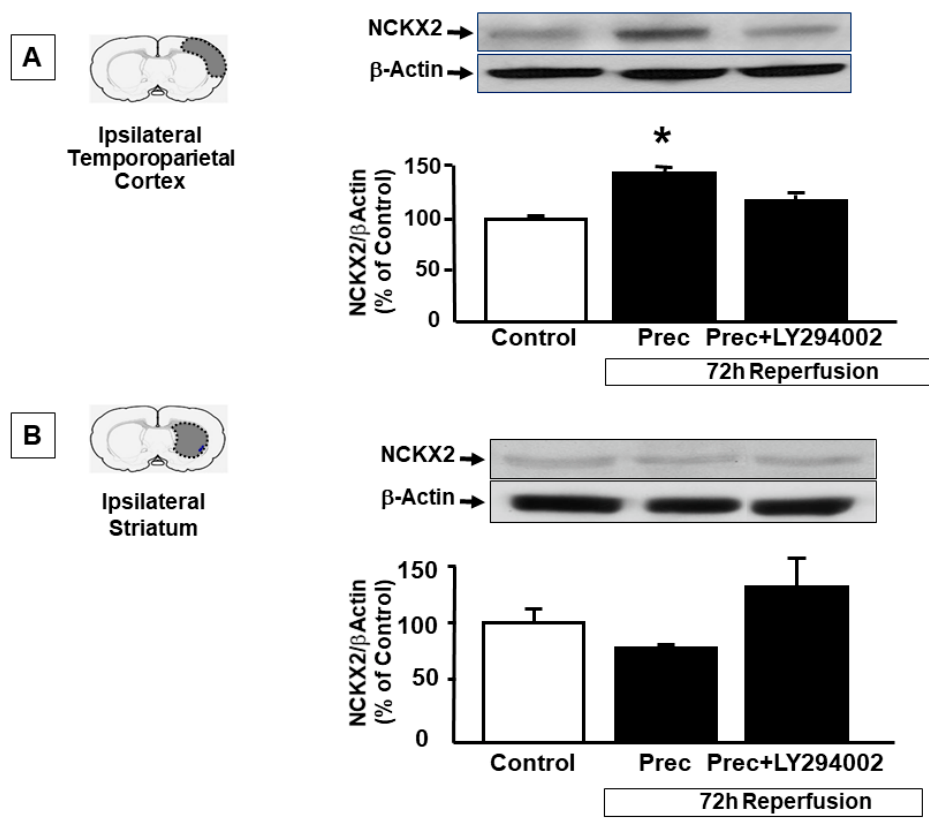
Figure 4. EFFECT OF THE pAKT INHIBITOR LY2940002 ON NCKX2 EXPRESSION DURING PRECONDITIONING IN CORTEX AND STRIATUM. ( A ) Western blot analysis of NCKX2 protein levels in the temporoparietal cortex of sham-operated animals, rats subjected to preconditioning and treated with vehicle or rats treated with the pAKT inhibitor LY294002 and then subjected to preconditioning stimulus. All the animals were sacrificed 72 h after the surgery. ( B ) Western blot analysis of NCKX2 protein levels in the ipsilateral striatum of sham-operated animals, rats subjected to tMCAO and treated with vehicle or rats treated with the pAKT inhibitor LY294002 and then subjected to preconditioning stimulus. All the animals were sacrificed 72 h after the surgery. Values are mean ± SEM. * p < 0.05, compared with control group. n = 3–5 animals for each column.